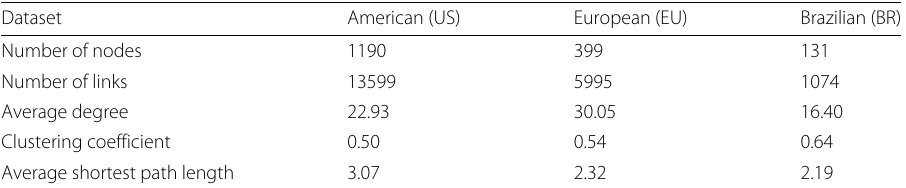
Table 4 Statistics of air-traffic